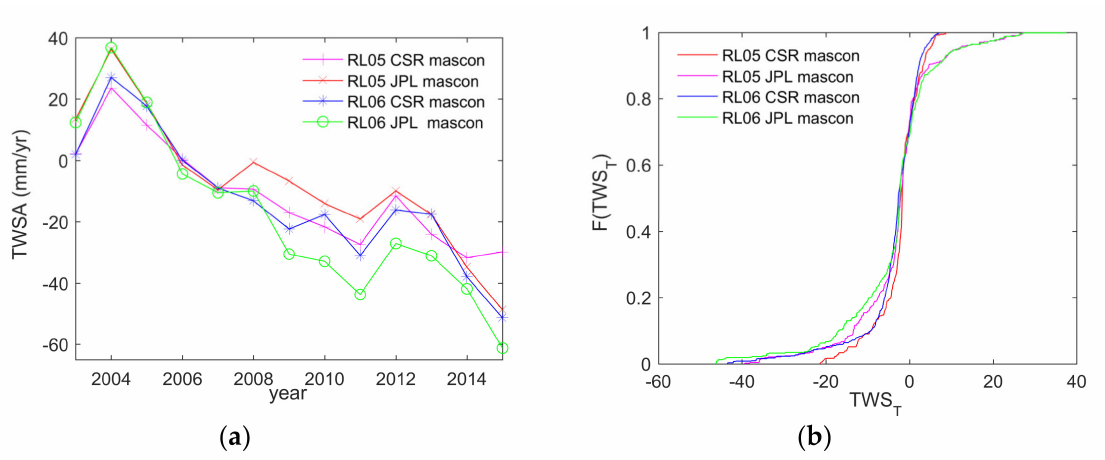
Figure 2. ( a ) Inter-annual TWSA across UMYRC and ( b ) empirical cumulative distribution functions for grid trend slope of TWS. TWS T is for the slope of TWS.